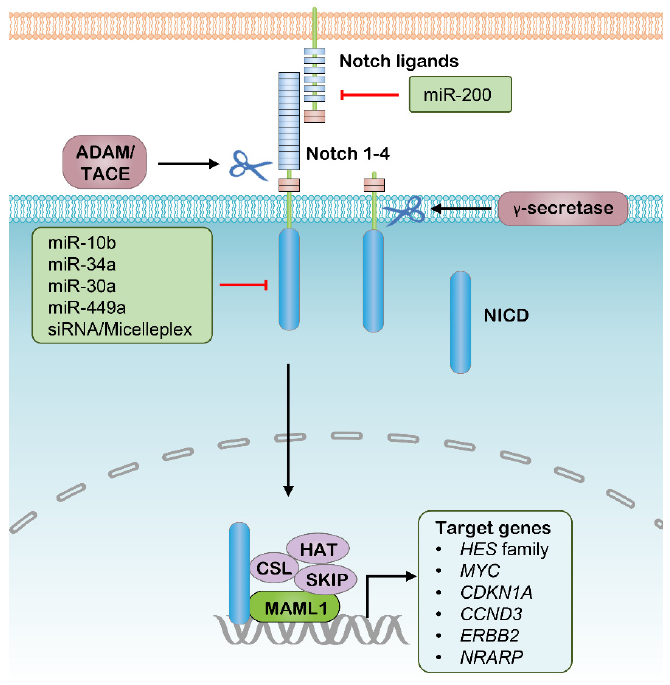
Figure 2. The canonical Notch signaling pathway and potential RNAi targets. ADAM, Disintegrin and metalloproteinase domain–containing protein; TACE, Tumor necrosis factor– α converting enzyme; NICD, Notch intracellular domain; CSL, CBF1/Su(H)/Lag–1; HAT, Histone acetyltransferase; SKIP, Ski–interacting protein; MAML1, Mastermind–like 1.